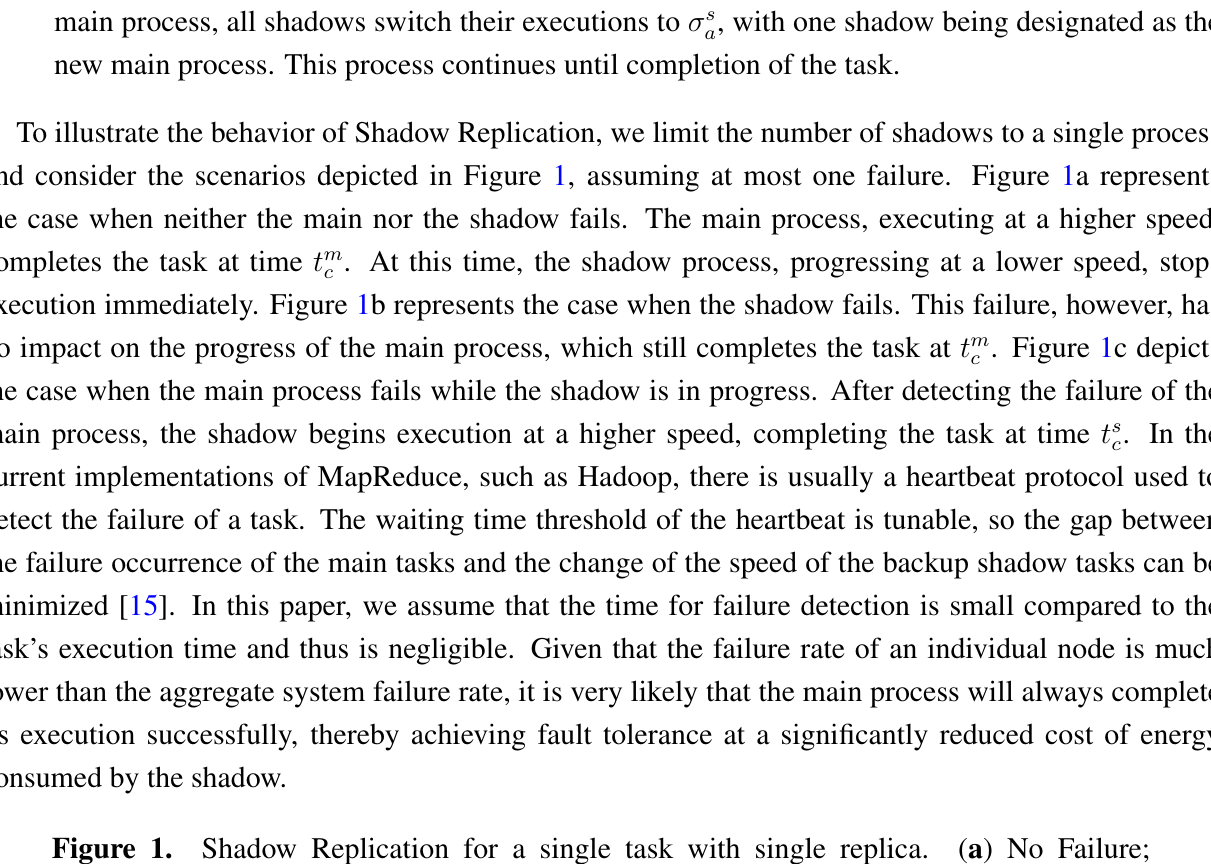
Figure 1. Shadow Replication for a single task with single